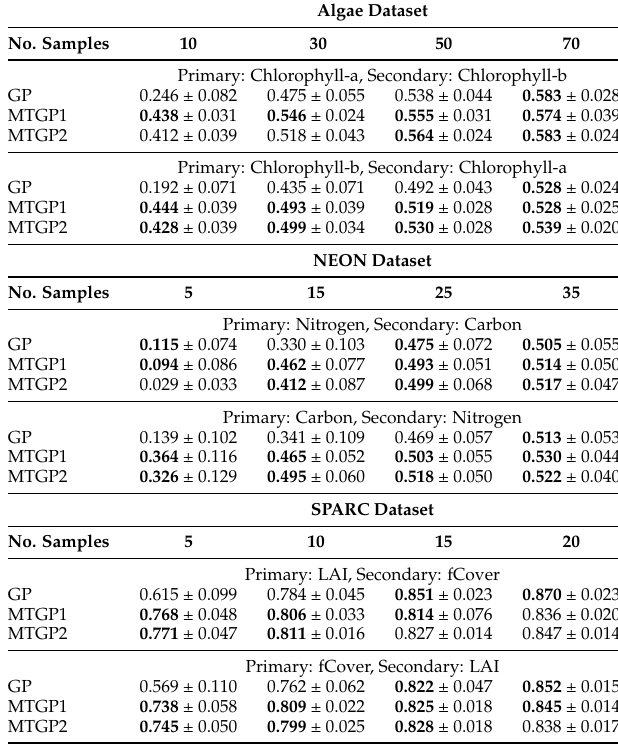
Table 5. Comparison of GP and multitask GP for vegetation parameter estimation. Performance measured by R 2